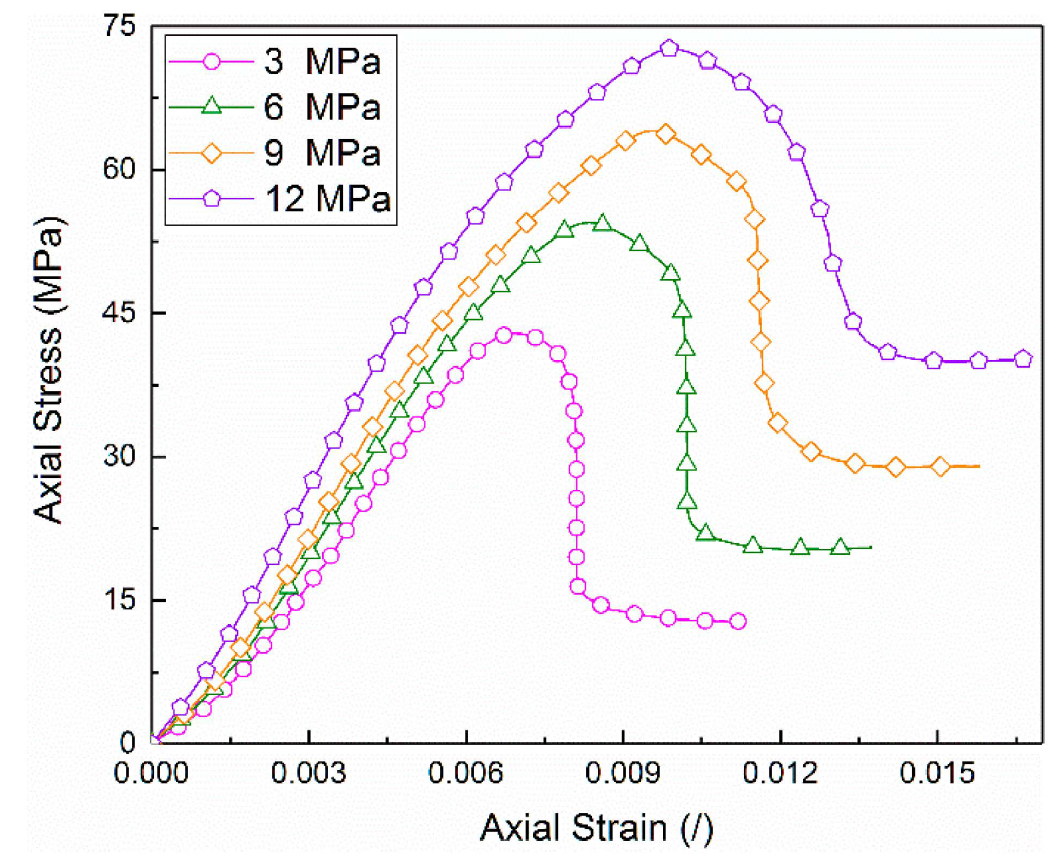
Figure 10. Stress–strain curves for sandstone specimens at different confining pressures (20 F&T weathering